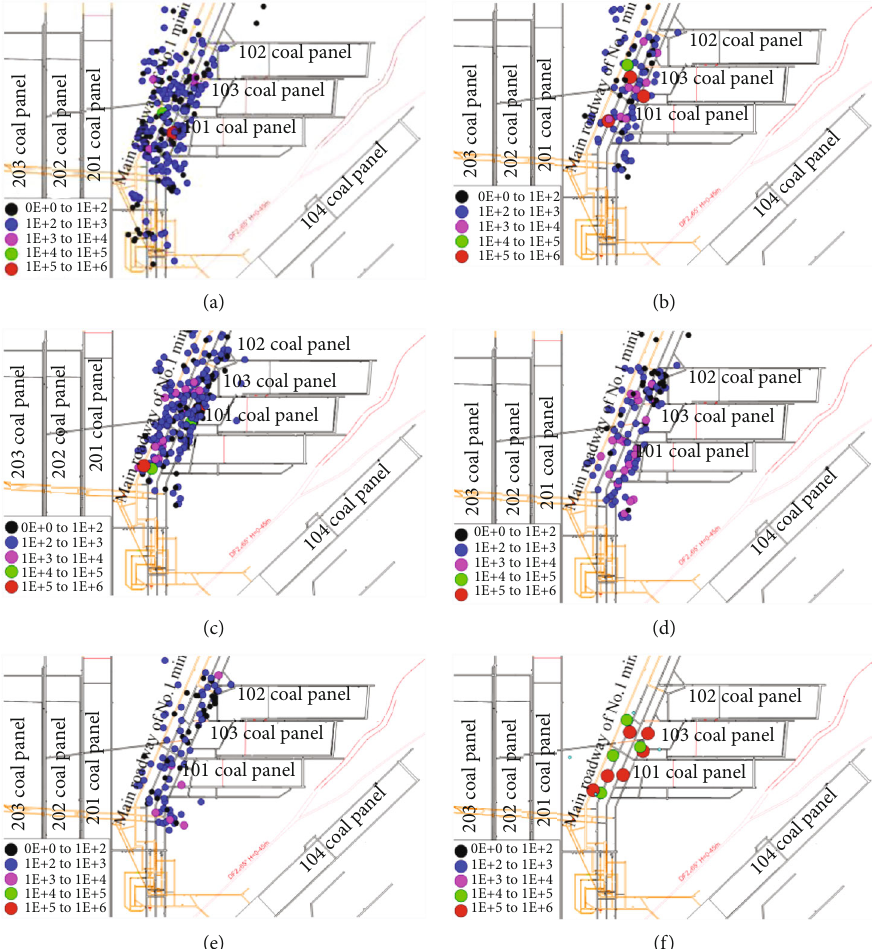
Figure 12: Plane distribution of microseismic events before and after prevention and control of main roadway. (a) August 2017;